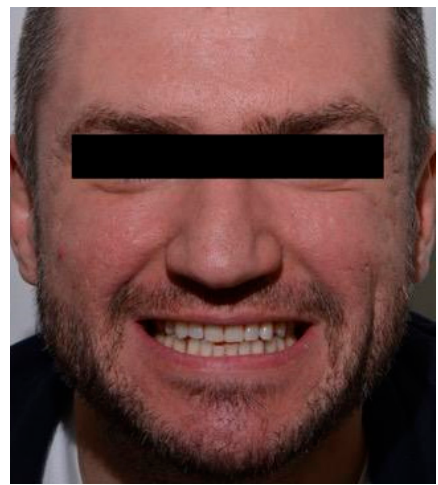
Figure 1. Initial extra-oral smile photo.